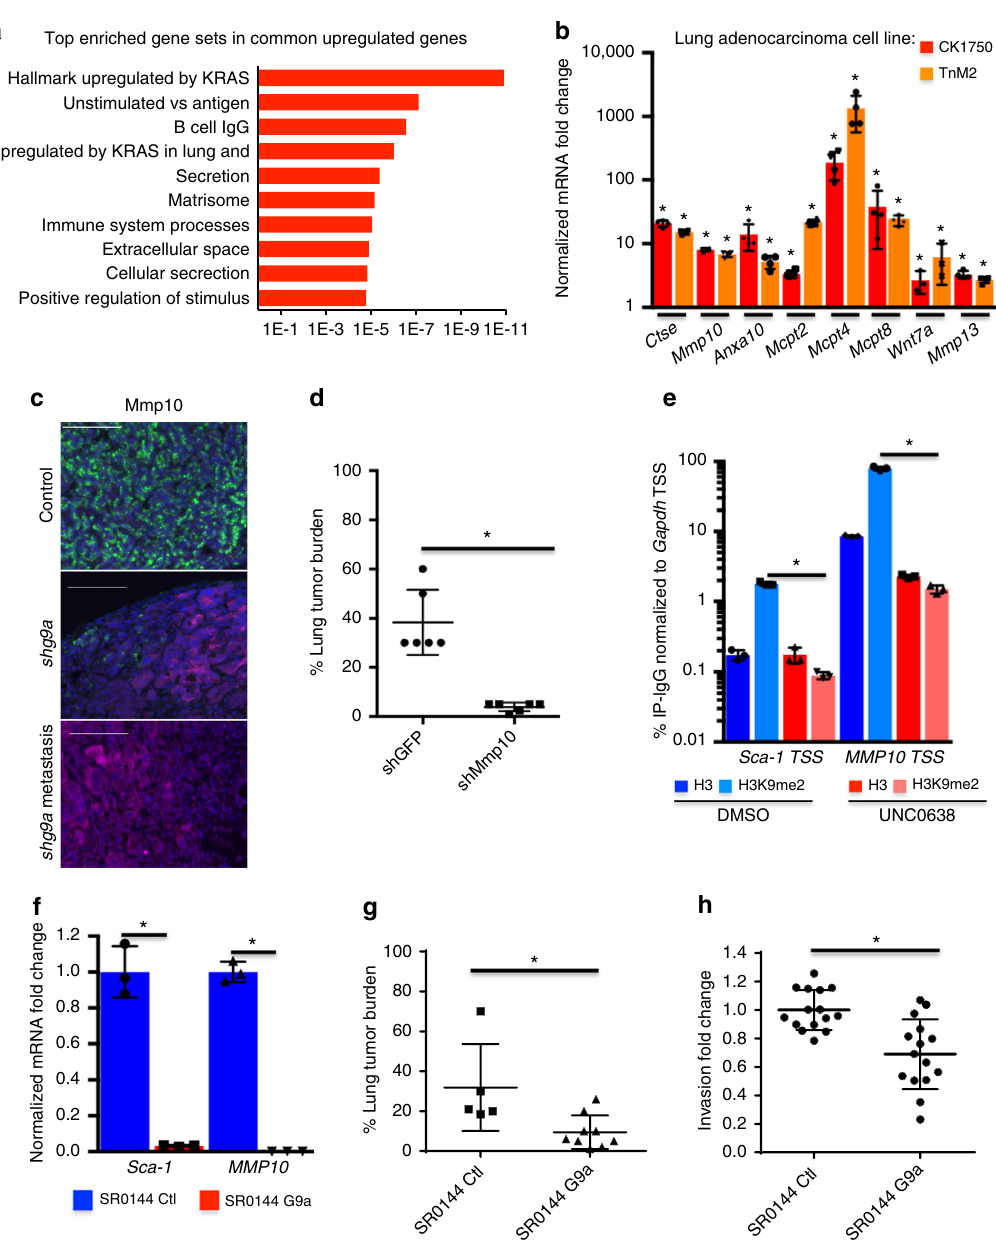
Fig. 3 G9a controls TPCs through KRAS-associated and ECM-associated genes. a Molecular Signatures Database enrichment of gene terms associated with genes upregulated upon G9a/Glp inhibition. b Bar chart of fold change of Gapdh -normalized mRNA levels of indicated genes in adenocarcinoma cells treated with 1 µ M UNC0638 relative to DMSO-treated controls. Error bars denote standard deviation. * P < 0.05, Fisher ’ s t test, n = 4. c Representative ( n = 5) images of shLuc control, and shG9a lung tumors and shG9a metastases immunostained for the indicated proteins. Scale bar = 100 µ m. d Chart of % lung tumor area per H&E-stained section from recipients of intravenously injected shGFP , and shMmp10 SR0144 shG9a lung adenocarcinoma cells. * P < 0.05, Fisher ’ s t test. e Representative bar chart of % immunoprecipitation compared to input DNA – IgG of H3 and H3K9me2 ChIPs at the indicated TSS relative to Gapdh TSS of lung adenocarcinoma cells treated with 1 µ M UNC0638 or DMSO. Error bars denote standard deviation. * P < 0.05, Fisher ’ s t test, n = 3 technical replicates. f Bar chart of mRNA from the indicated genes normalized to Gapdh from control and G9a-overexpressing SR0144 shG9a lung adenocarcinoma cells. Error bars denote standard deviation, * P < 0.05, Fisher ’ s t test, n = 3. g Chart of % lung tumor area per H&E-stained section from recipients of intravenously transplanted control and G9a-overexpressing SR0144 shG9a lung adenocarcinoma cells. * P < 0.05, Fisher ’ s t test. h Chart of fold change in invasion through a 3D matrix-coated migration transwell of G9a-overexpressing relative to control SR0144 shG9a lung adenocarcinoma cells. * P < 0.05, Fisher ’ s t test culture being comparable to controls (Supplementary Fig. 7c). cells (Fig. 3f), we observed signi fi cant downregulation of the G9a When shKdm3a cells were transplanted into mice, signi fi cantly targets Sca-1 and Mmp10 (Fig. 4f), suggesting that Kdm3a fewer lung and extra-lung tumors formed compared to control depletion may impede TPCs through the same mechanisms as cells (Fig. 4d, e), suggesting that the TPC properties of these cells G9a expression in lung adenocarcinoma cells. When we returned were also impaired. Similarly to rescued shG9a adenocarcinoma to our primary mouse adenocarcinoma data, we found that a NATURE COMMUNICATIONS| (2018) 9:4559 |DOI: